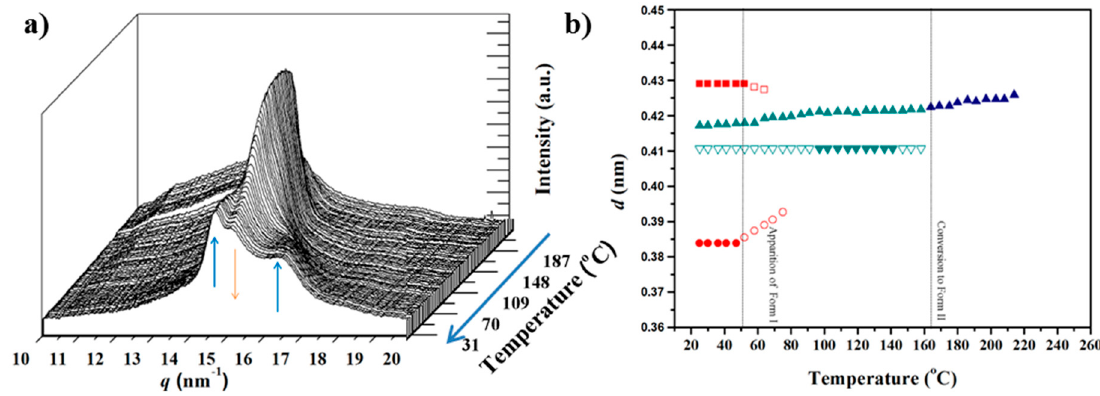
Figure 8. ( a ) Three-dimensional representation of WAXD profiles of nylon 4 9 during cooling (10 °C/min) from the melt to room temperature; and ( b ) evolution of the spacings of the two main reflections during the cooling run. Full and empty symbols indicate well-defined and intuited reflections, respectively. The temperatures at which structural transitions occur are indicated with vertical lines. Reflections corresponding to Forms I, II and III are indicated in red, green and blue, respectively.